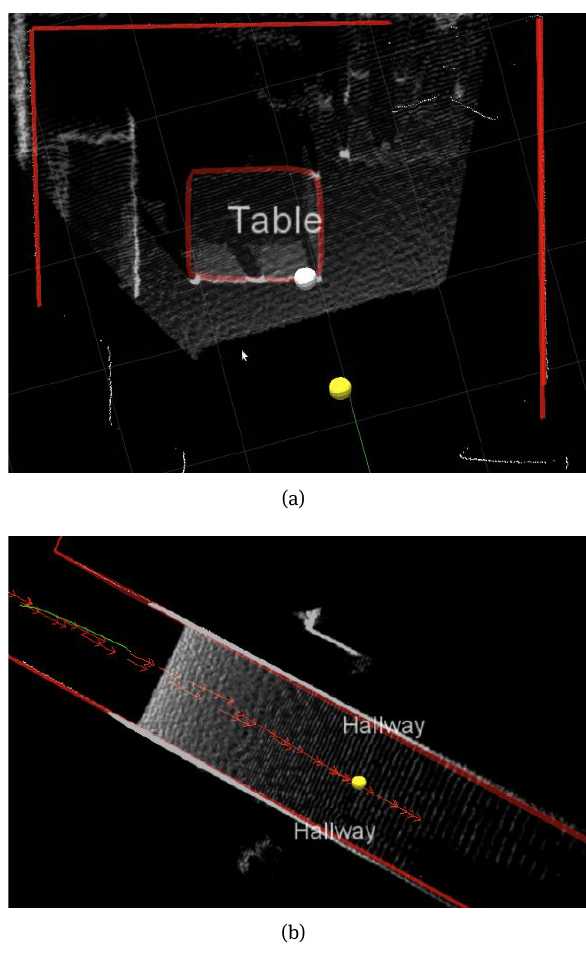
Figure 11: a) Top down point cloud view of a room. A planar land- mark with the label Table has previously been annotated by a user. The convex hull for the planar landmark is shown in red lines. When asked to navigate to Table , the robot calculates a goal position, which is shown as the yellow point; b) Top down point cloud view of a hallway. The user has previously annotated two planar landmarks with the same label: Hallway . When asked to navigate to Hallway , the robot chooses a goal position in the middle of the planar land- marks which is shown as the yellow